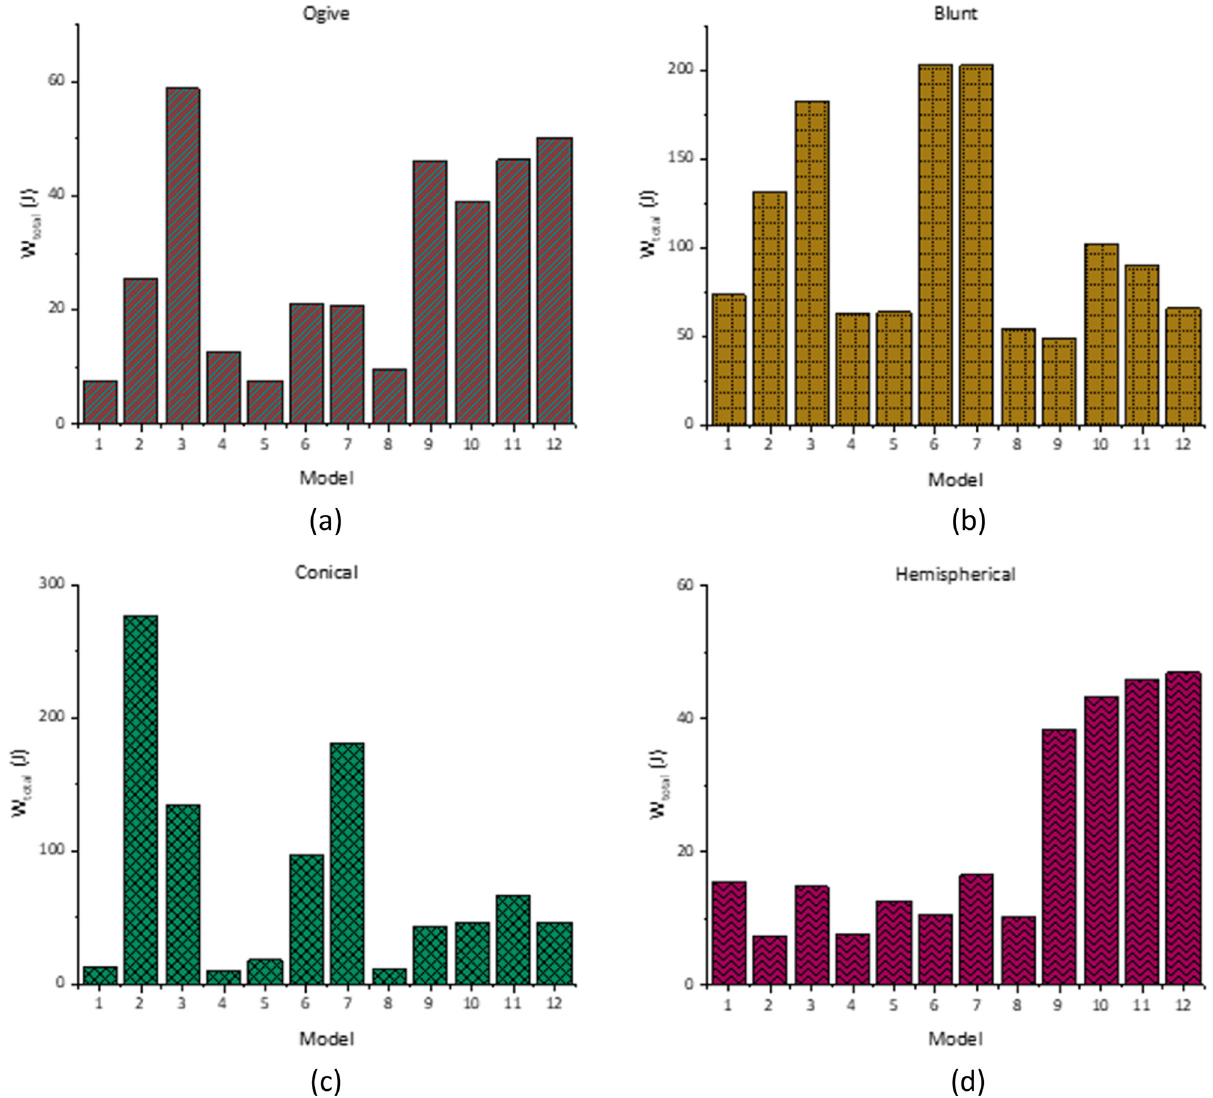
Figure 23: Energy absorption for projectile shapes: ( a ) ogive, ( b ) blunt, ( c ) conical, and ( d )